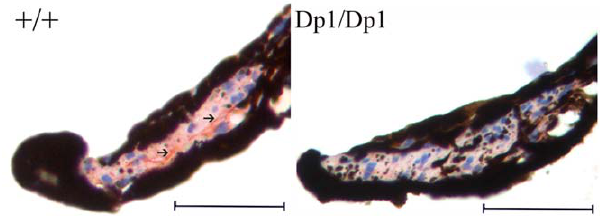
Figure 6. Immunohistochemistry results reveal the severe reduction of the ChRM3 receptor in the iris constrictor muscles of Dp1 homozygotes. Representative iris sections from wild-type and homozygous mice. Staining of an anti-ChRM3 receptor antibody is shown in red and is indicated by an arrow. Scale bars: 50 m m.